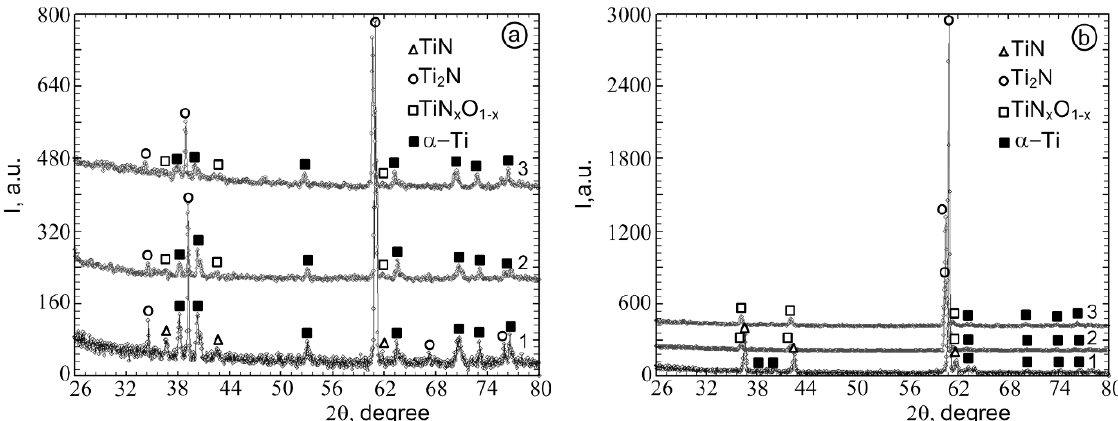
Figure 1. X-ray diffraction patterns of Ti-6Al-4V alloy after nitriding (1); low-temperature oxidation (2) and high-temperature oxidation (3) of nitride coating based on Ti N phase (a) and TiN phase (b). 2